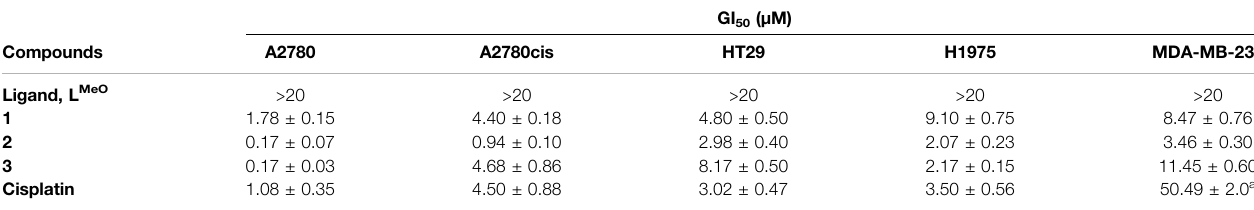
TABLE 1 | Effect of tris-arylphosphane ligand and complexes 1 – 3 on cell growth. Results are expressed as GI 50 values ± SD of at least three independent experiments in duplicate. Cisplatin is reported as